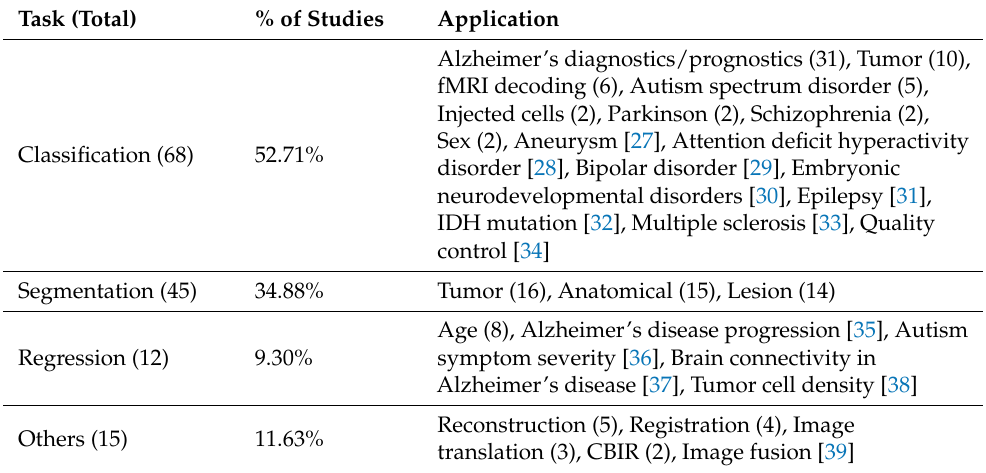
Table 3. Tasks and applications in the surveyed